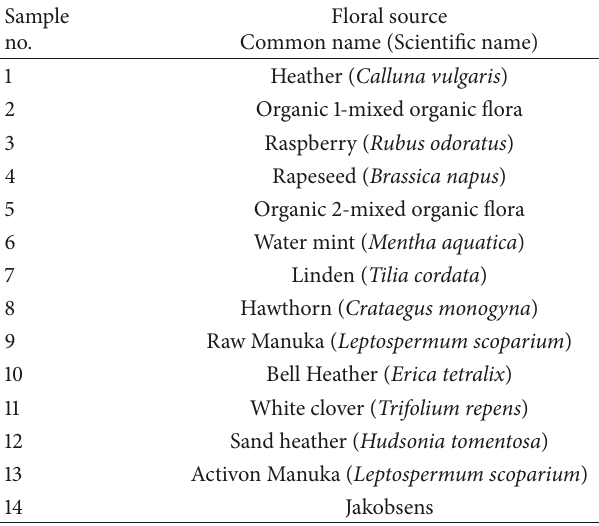
Table 1: Honey samples included in the study. The Danish samples were obtained by two local beekeepers from the Zealand Region. The Activon Manuka is a medical grade honey and was obtained from Advancis Medical. The raw Manuka was obtained from a local beekeeper in New